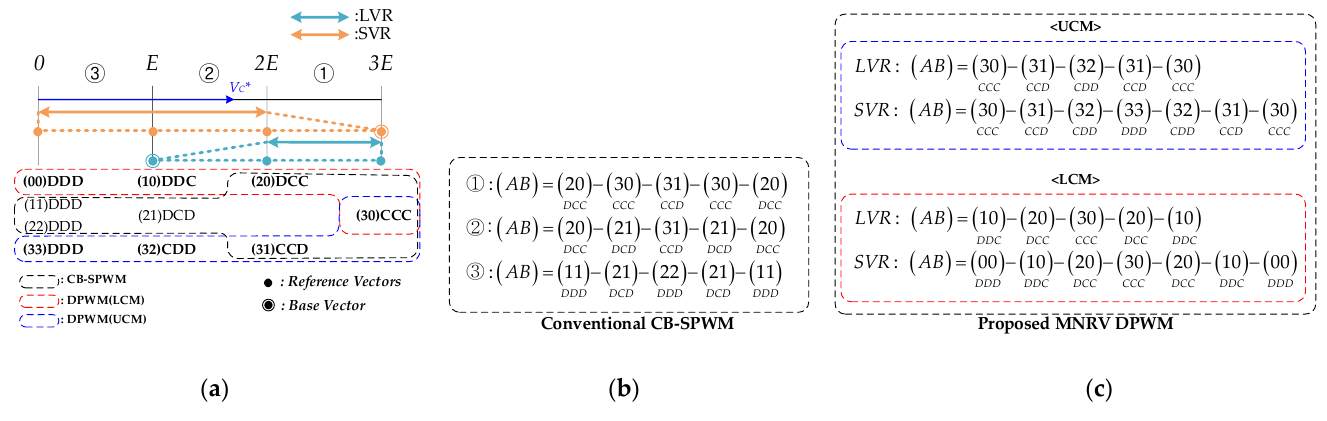
Figure 2. Implementation example of MNRV DPWM for a single-phase diode-clamped four-level PWM converter: ( a ) selection of MNRVs according to the V C* position, ( b ) switching patterns of the conventional CB-SPWM, and ( c ) those of the proposed MNRV DPWM.